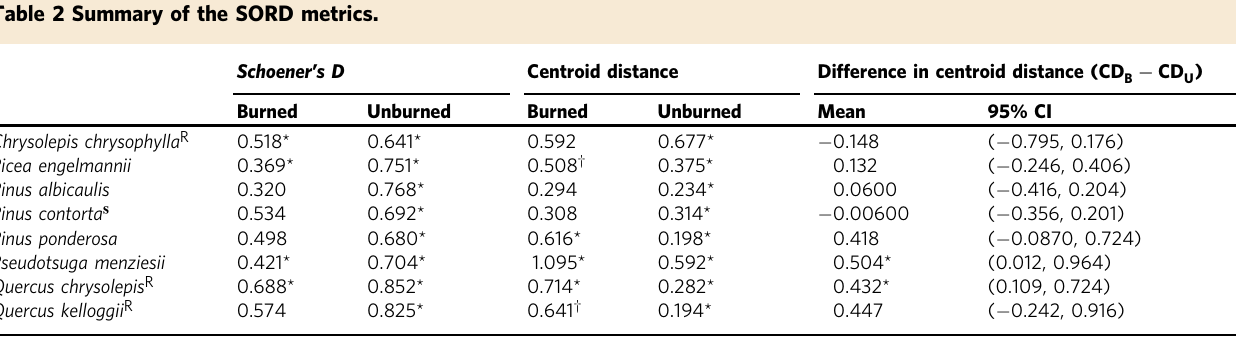
Table 2 Summary of the SORD